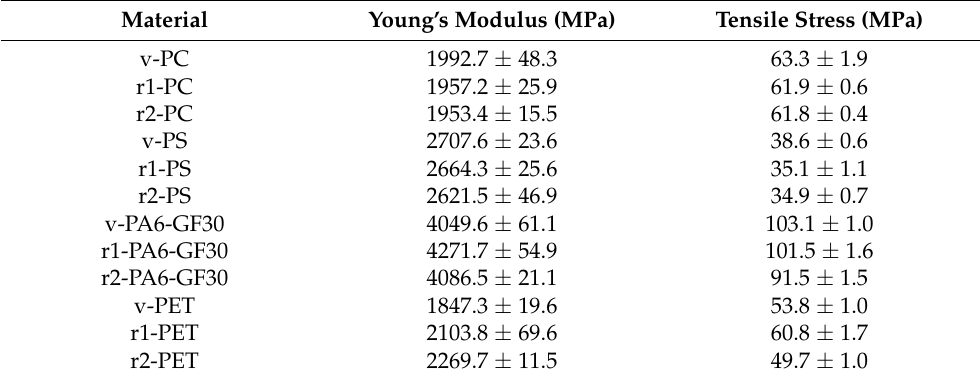
Table 5. Mechanical properties for virgin and recycled materials tested according to the guidelines in ISO 527:2019 [23].